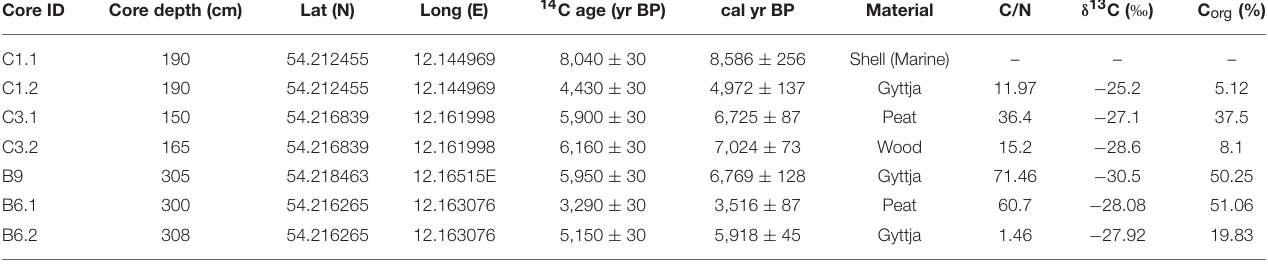
TABLE 1 | Available age control 14 C in the study area. Age intervals are given at a 95.4% confidence interval. Core